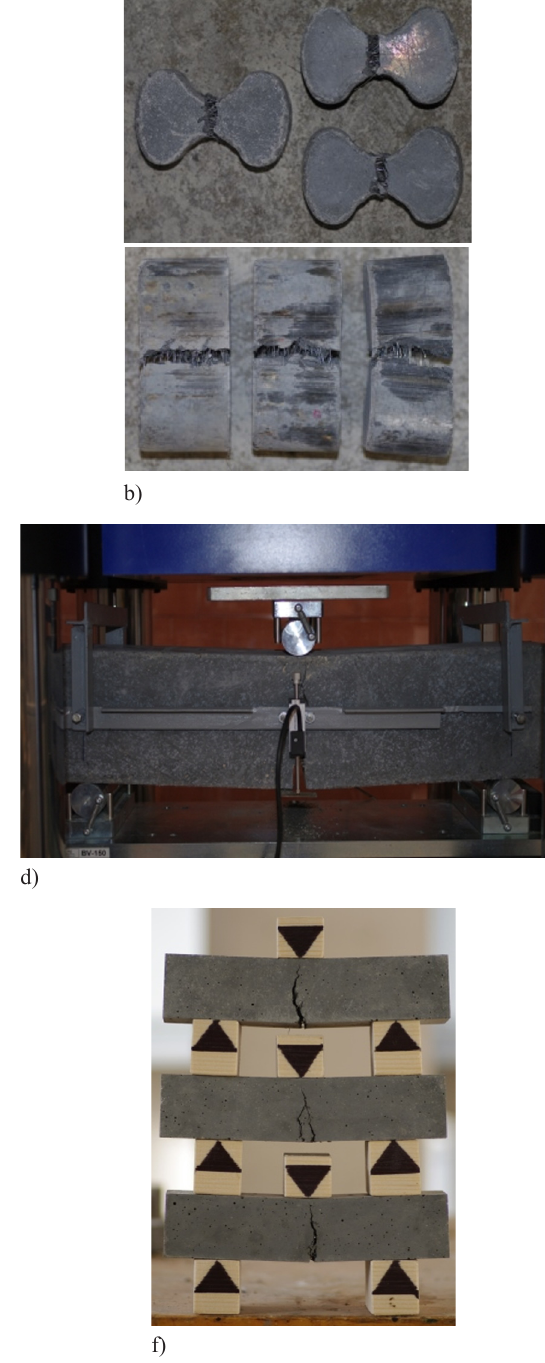
Fig. 4. HPFRCC material samples of different shapes and sizes: (a) and (b) samples after tension, (c) testing of prisms (40×40×160), (d) flexural test of prisms (150×150×600), (e) – flexural test of prisms (100×100×400), (f) – prisms (40×40×160) after flexural